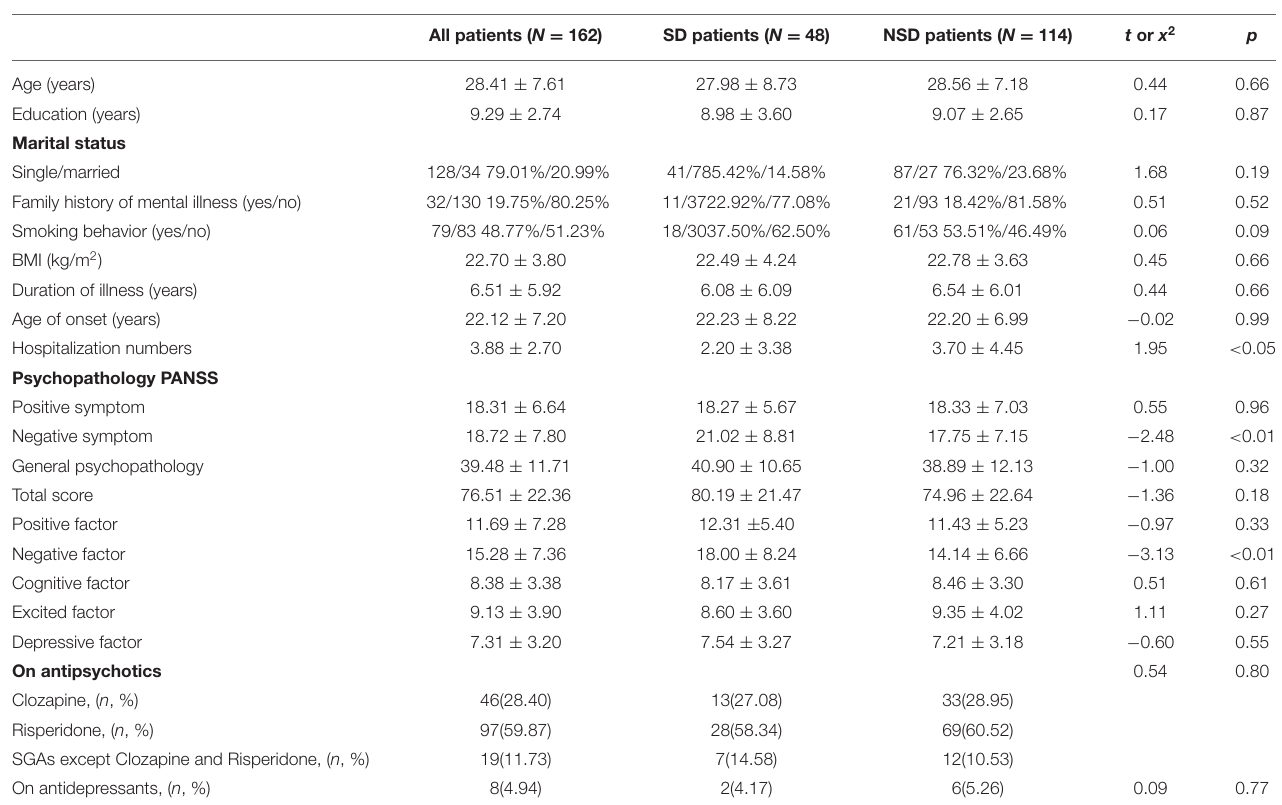
TABLE 2 | Characteristics of schizophrenia patients with or without sexual dysfunction